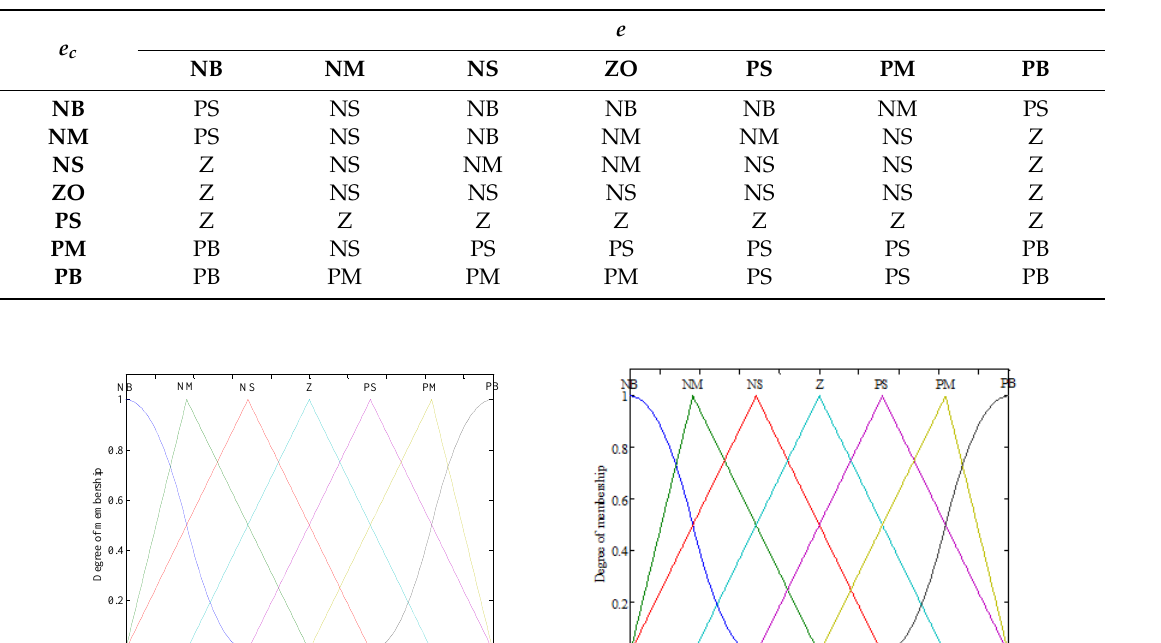
Table 3. Fuzzy rule of K d .